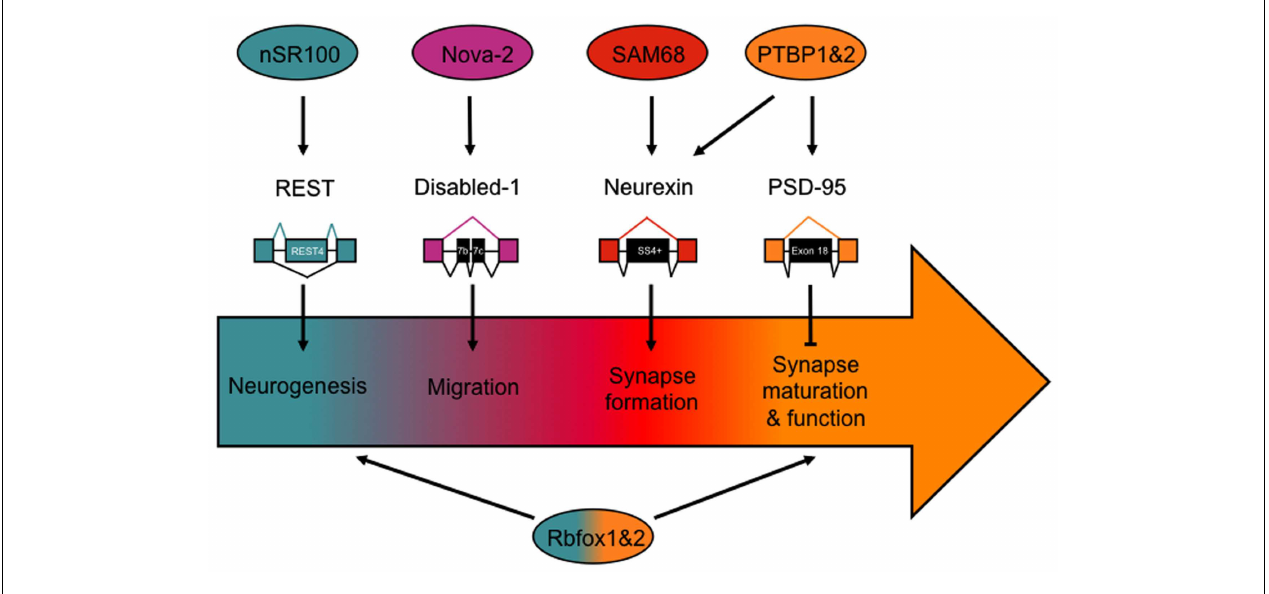
beginning with neurogenesis, and ending with synapse maturation and function. Splicing factors and target transcripts are correspondingly color coded to the developmental stage in which they are known to be